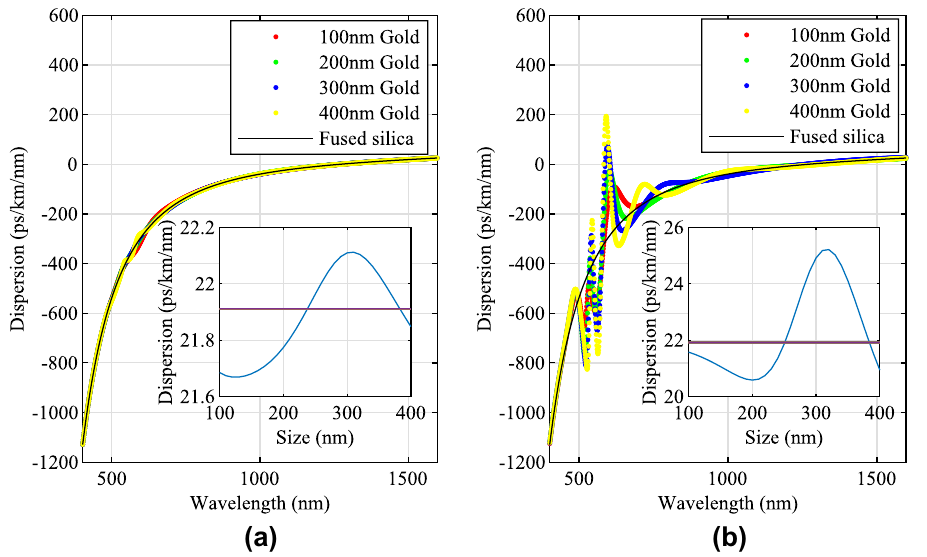
Figure 8. The material dispersion of gold NP-doped optical fibres. ( a ) The cases of material dispersion of 1 cm length gold NP-doped optical fibres with the maximum concentrations for single scattering restriction. The red dots show the case for 100 nm size gold NPs. The green dots show the case for 200 nm size gold NPs. The blue dots show the case for 300 nm size gold NPs. The yellow dots show the case for 400 nm size gold NPs. The black lines show a reference of material dispersion of fused silica. The embedded graph shows the dispersion of 1 cm length gold NP-doped optical fibres with the maximum concentrations for single scattering restriction for different sizes of gold NPs from 100 to 400 nm at 1550 nm incident light in blue lines. The purple lines show the dispersion of fused silica at 1550 nm. ( b ) The cases of material dispersion of 1 cm length gold NP-doped optical 4 10 fibres with a fixed volume ratio of 1 . The red, green, blue, yellow dots show the case for 100 nm, 200 nm, − × 300 nm and 400 nm gold respectively. The black lines show the dispersion of fused silica. The embedded graph 4 10 shows the dispersion of 1 cm length gold NP-doped optical fibres with volume ratio of 1 for different − × sizes of gold NPs at 1550 nm incident light in blue lines. The purple lines show the dispersion of fused silica at 1550